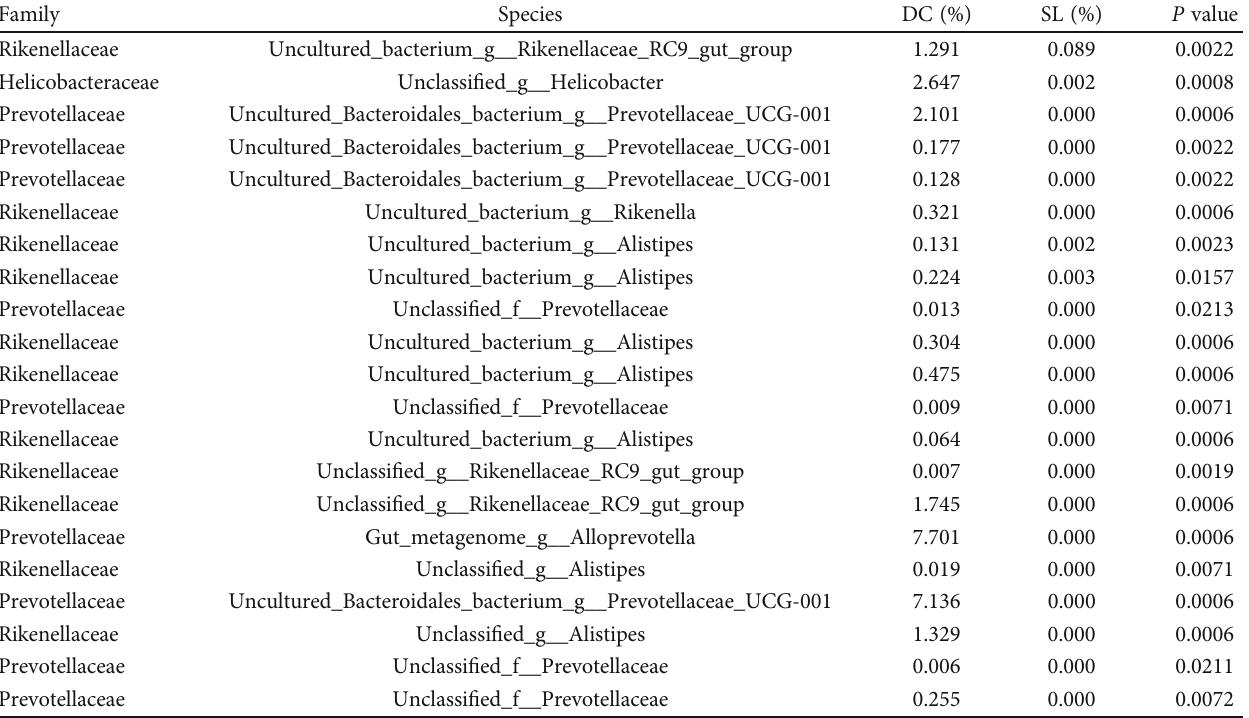
Table 2: The relative abundance of 21 species reduced by SL.